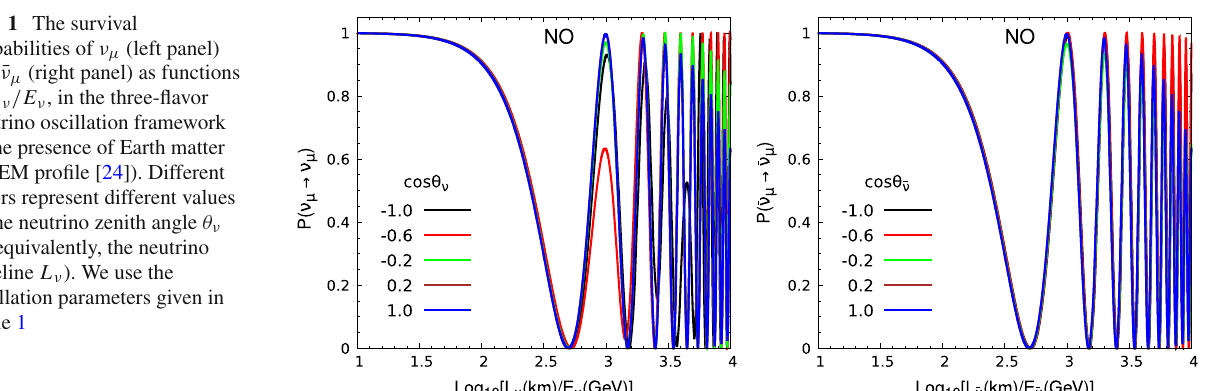
Table 1 The values of the benchmark oscillation parameters used in this analysis. These values are in good agreement with the current global fits [6–9]. Normal mass ordering corresponds to m 1 < m 2 < m 3